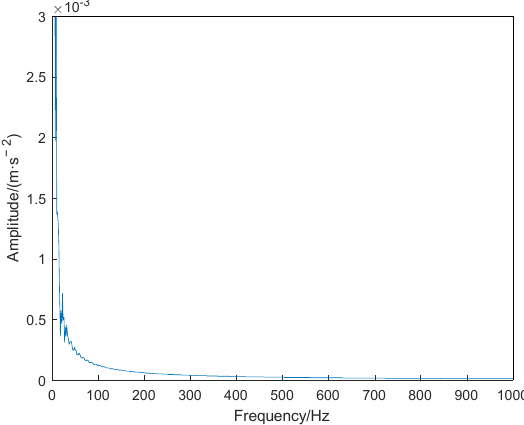
Figure 8. CEEMDAN optimal component envelope spectrum.